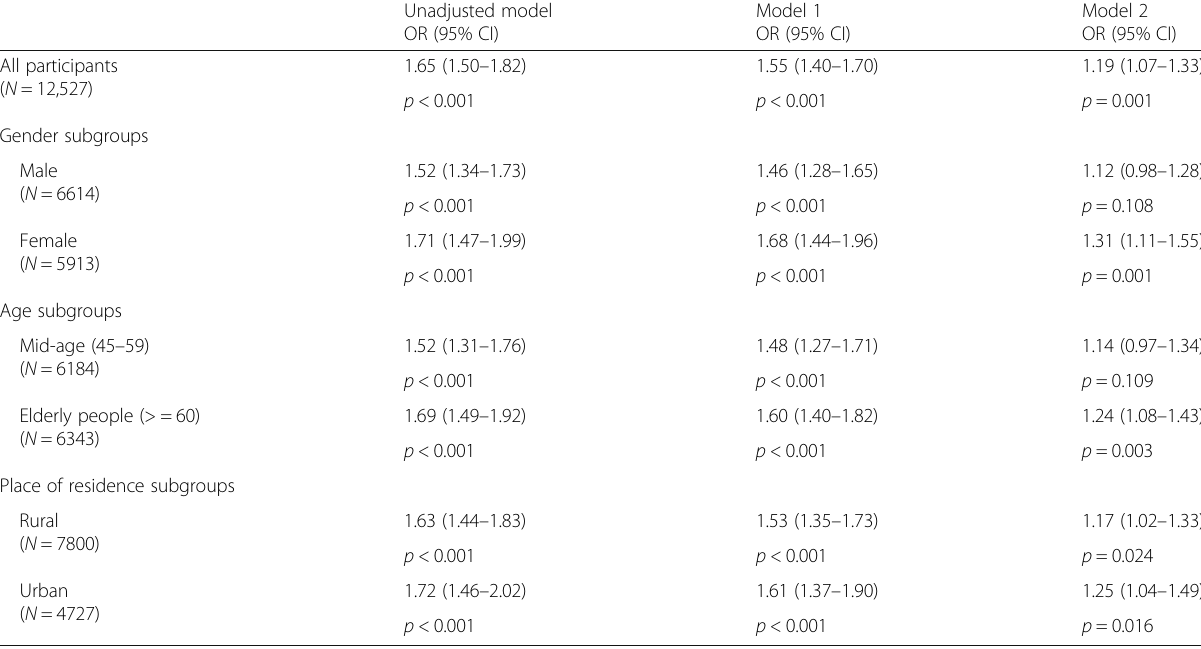
Table 4 Logistic regression analysis of depressive symptoms (CES-D ≥ 10) and subsequent fall accidents among